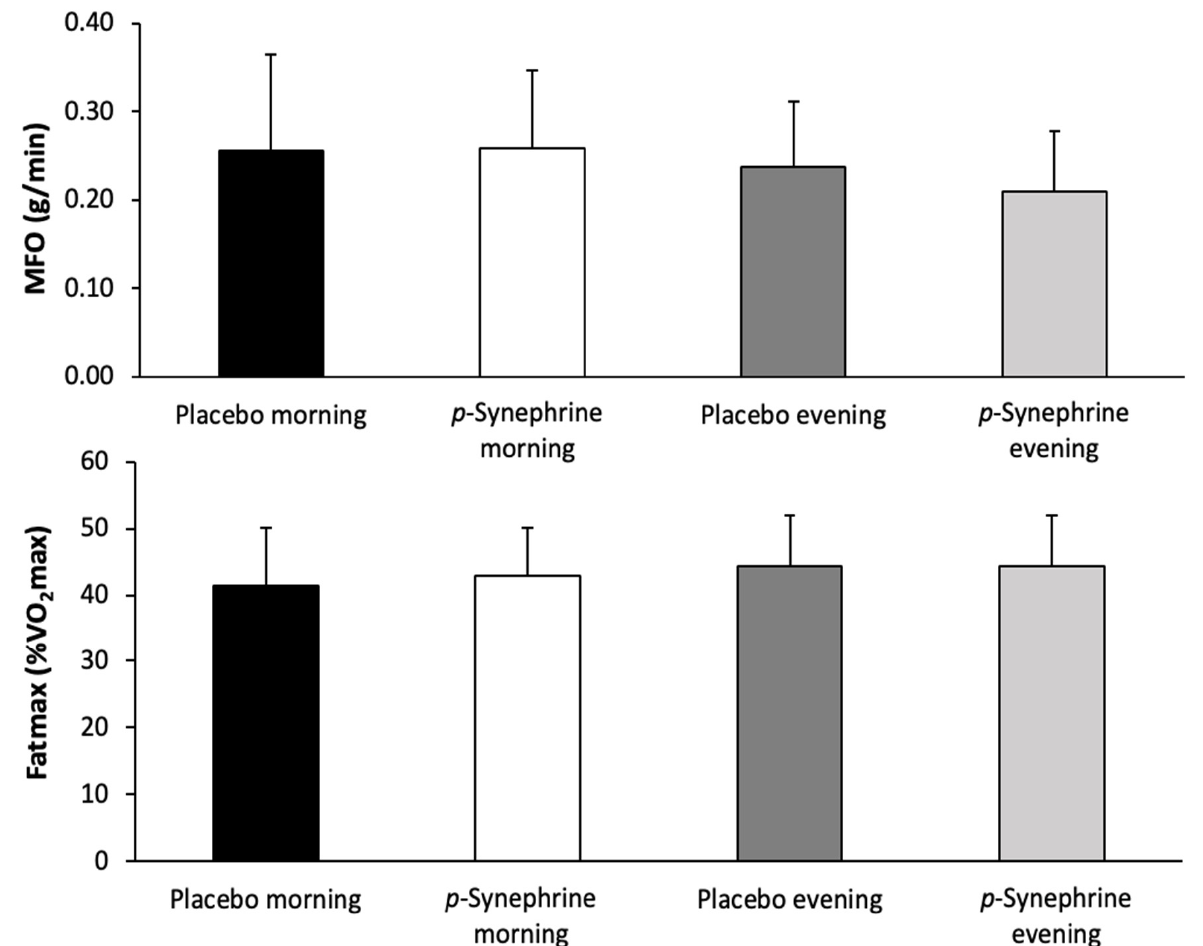
Figure 1. Maximal fat oxidation rate (MFO, in g/min; upper panel) and exercise intensity at MFO (Fatmax, as percentage of maximal oxygen uptake (VO 2 max); lower panel) during exercise of in- creasing intensity performed in the morning (8:00–10:00 h) or the evening (17:00–19:00 h) after the ingestion of 3 mg/kg of p -synephrine or a placebo in